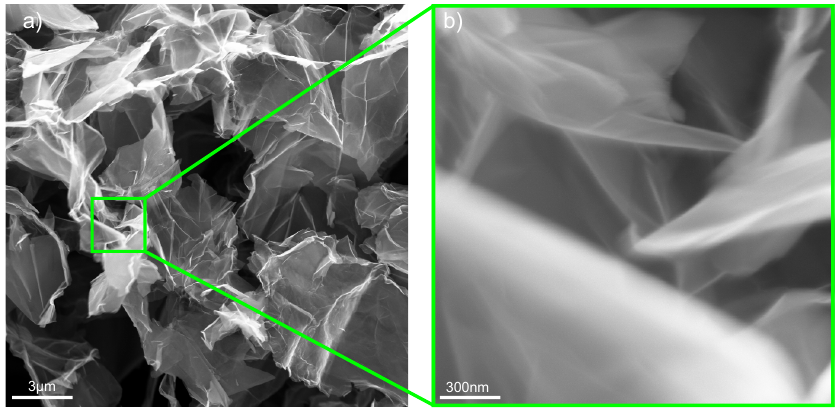
Figure A8. SEM images for ExG at magnifications of ( a ) 10k and ( b ) 150k.